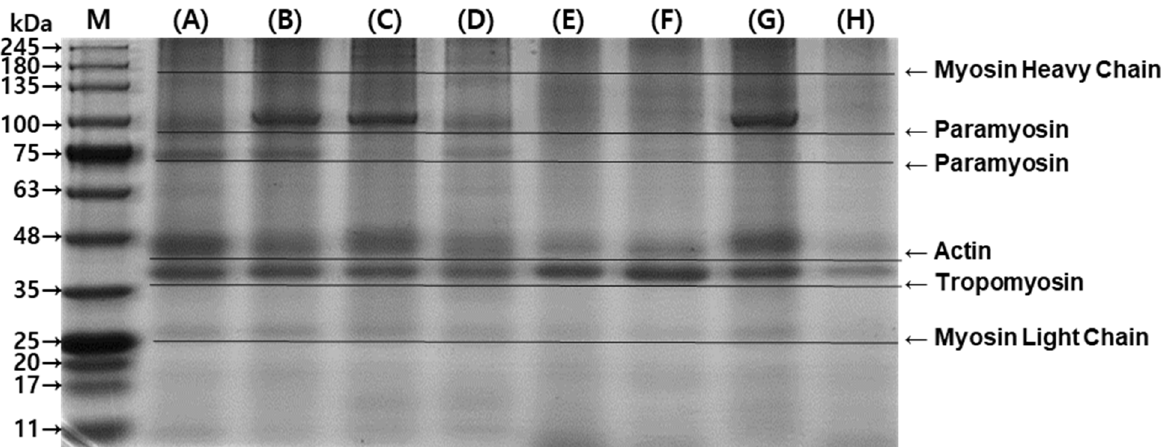
Figure 6. Composition of raw and sous vide-cooked abalone protein extracted under different extraction conditions. ( A ) Raw abalone in phosphate buffer (PB) + EDTA, ( B ) raw abalone in PB + EDTA + 0.6 M NaCl, ( C ) raw abalone in PB + EDTA + 16 mM SDS, ( D ) raw abalone in PB + EDTA + 8 mM Triton X-100, ( E ) sous vide-cooked abalone in phosphate buffer (PB) + EDTA, ( F ) sous vide-cooked abalone in PB + EDTA + 0.6 M NaCl, ( G ) sous vide-cooked abalone in PB + EDTA + 16 mM SDS, and ( H ) sous vide-cooked abalone in PB + EDTA + 8 mM Triton